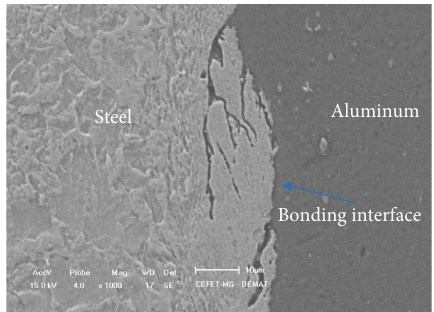
Figure 5: Welded joint (scanning electron microscope magnification 1000x).